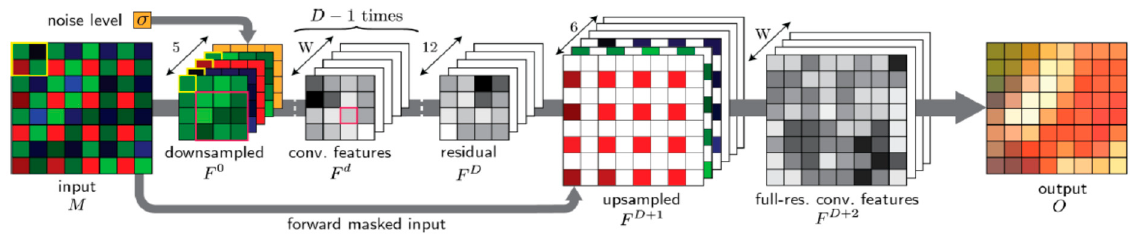
Figure 5. DEMONET architecture [35].